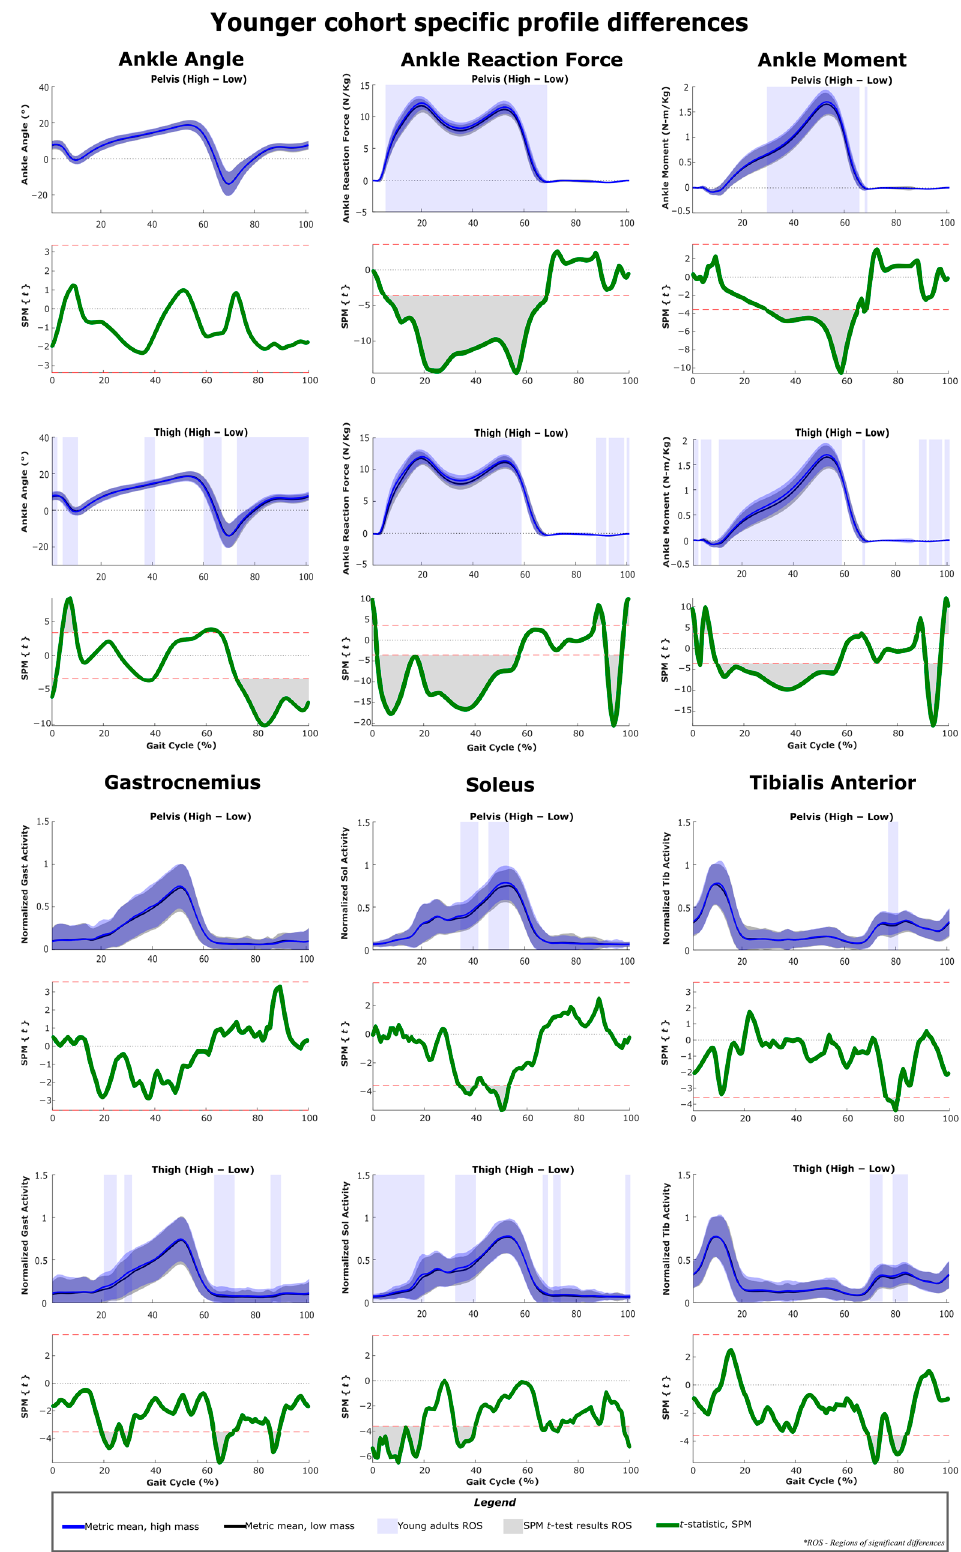
Figure 5. SPM t -test results and profile plots of the metrics, comparing low mass to high mass in the pelvis and thigh segments for participants in the younger cohort. Joint parameters are primarily related to the ankle joint. The t -statistic is qualitatively identical to the effect size and can be used as an indicator of practical significance.